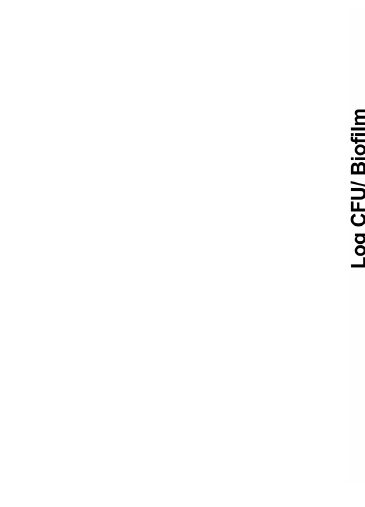
FIGURE 3 | Effect of compound Str7410 on the number of cells [determined as log colony-forming units (CFU)] in biofilms formed from mixed Pseudomonas aeruginosa PAO1 and Staphylococcus aureus ATCC 25923 cells. Treatments: Str7410 (10 μ M) alone, meropenem trihydrate (MEPM, 0.5 μ g/ml) alone, and MEPM combined with sonication or Str7410. Values are presented as the mean ± SD ( n = 3). Differences in data were compared with the untreated control at each time- point and considered significant when p < 0.05 (* p < 0.05, and ** p < 0.01) by one-way ANOVA with t -tests.